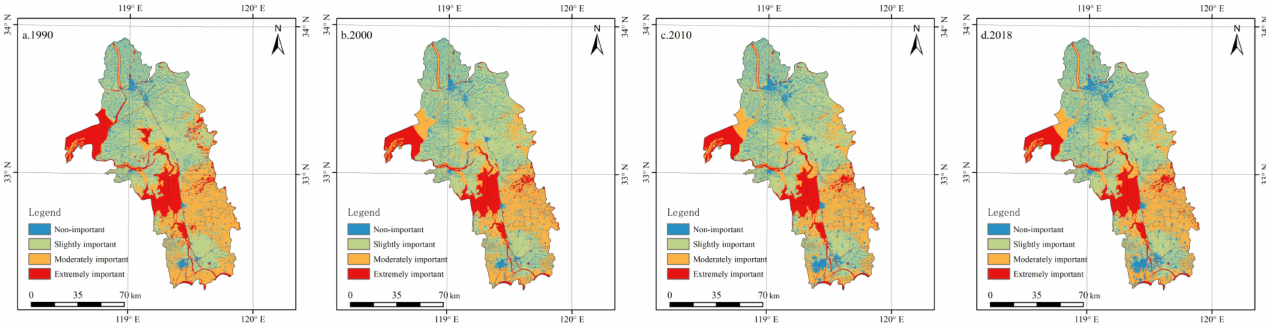
Figure 5. Spatial distribution of integrated ecosystem service in the Huaiyang Canal from 1990 to